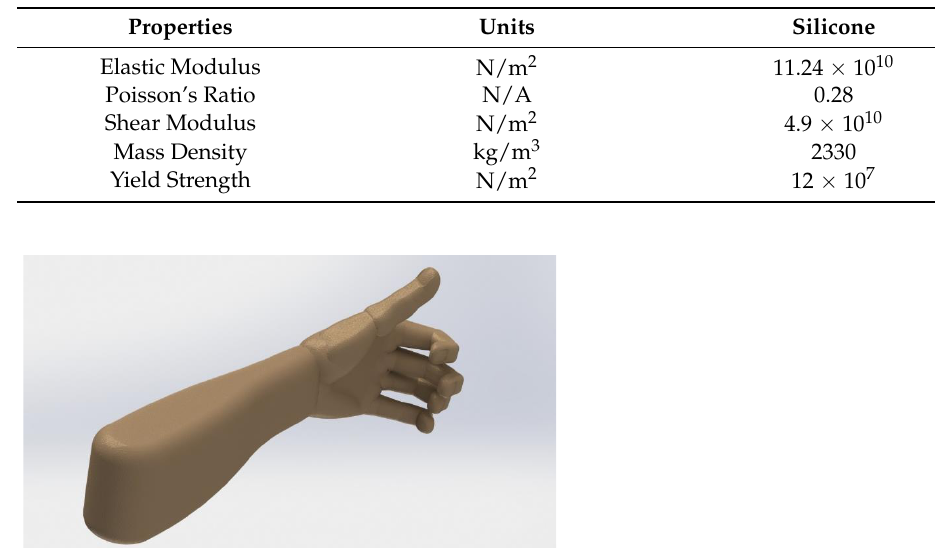
Table 2. Material characteristics of the ABS (Acrylonitrile Butadiene Styrene) material.